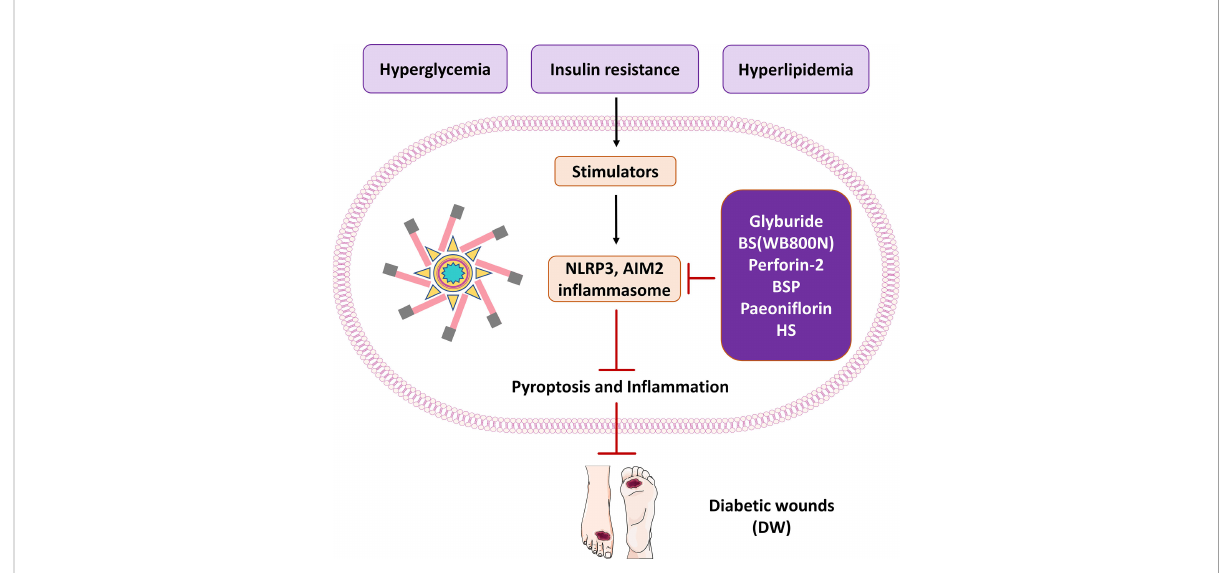
FIGURE 3 The therapeutic signi fi cance of potential molecules or materials for diabetic wound by inhibiting pyroptosis and in fl ammasome NLRP3 and